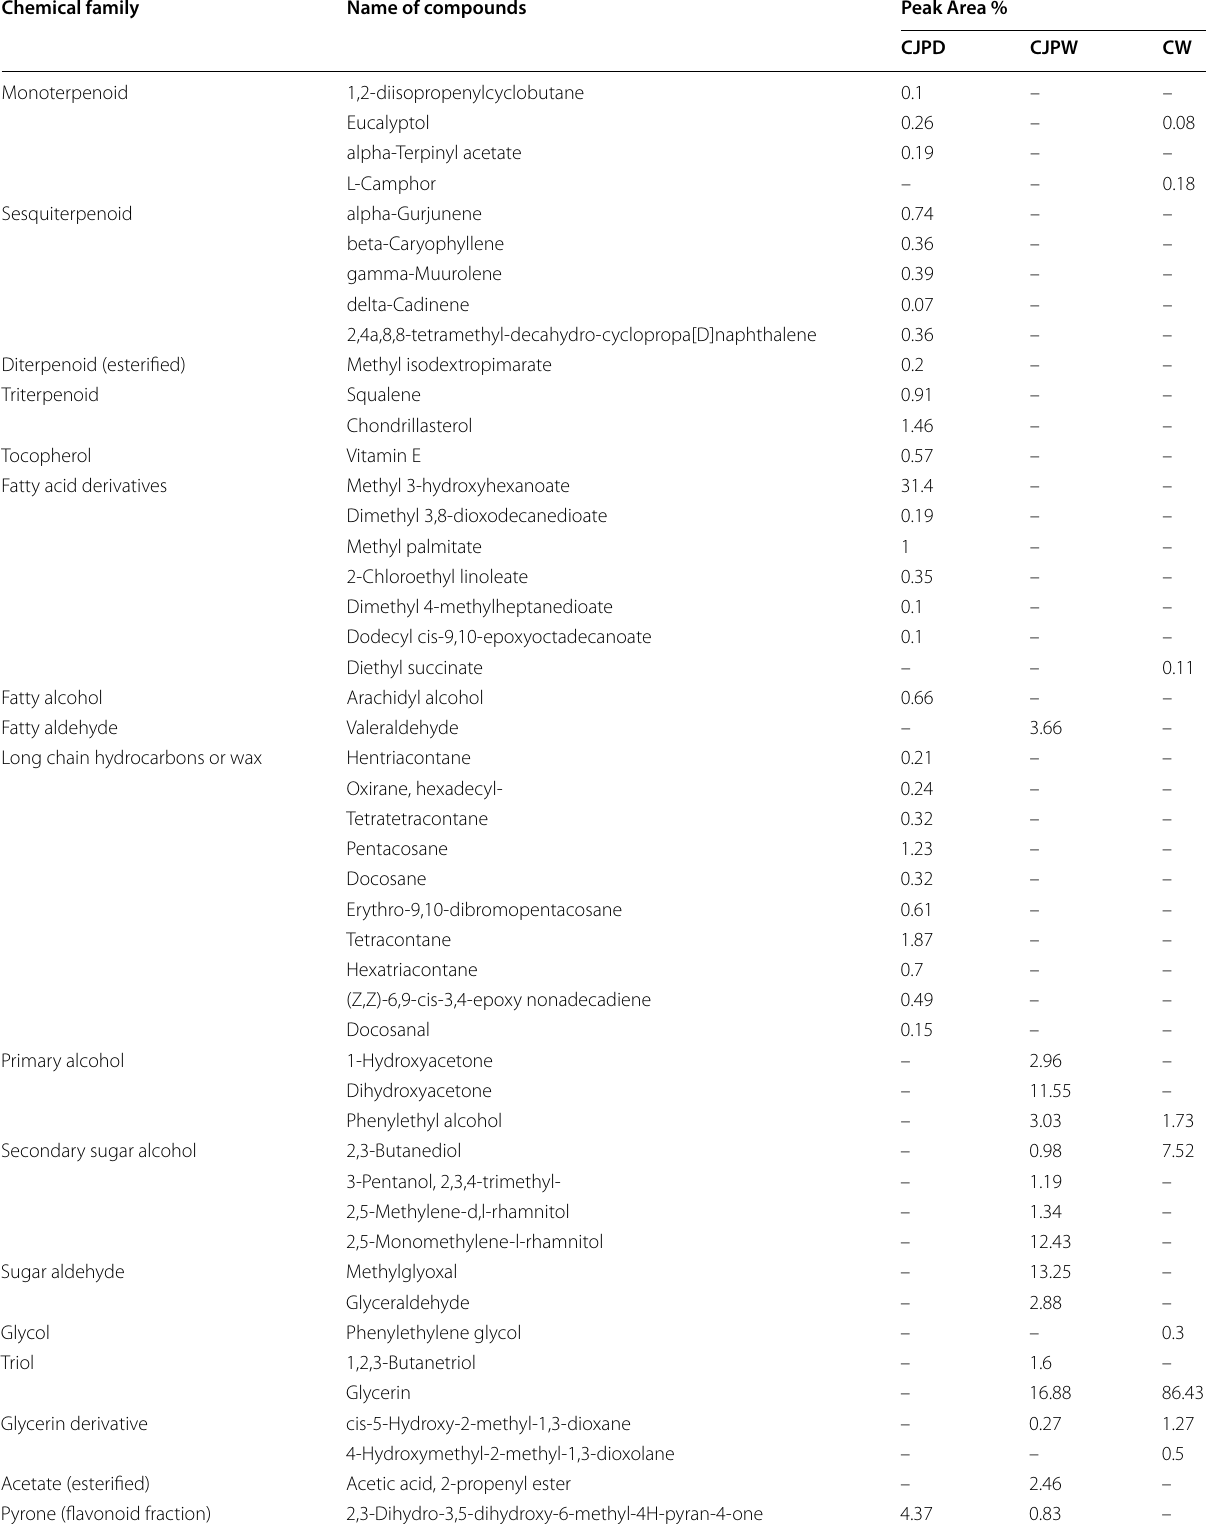
Table 1 Comparative table for metabolites (volatile profile) of CJPD, CJPW and CW detected by GC-MS analysis Chemical